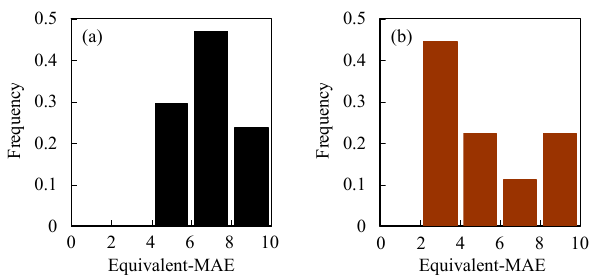
Fig. 3. Frequency distribution of the average equivalent-MAE for Figure 3. Frequency distribution of the average equivalent-MAE for Group 1 (a) and Group 2 (b) Group 1 (a) and Group 2 (b) shown in Table 1. The extremely high value (17.4m 2 g − 1 ) measured in Philadelphia, PA during se- shown in Table 1. The extremely high value (17.4 m 2 /g) measured in Philadelphia, PA during vere sulphate haze episodes occurred in the summer of 2002 was not included in (a) . Upper estimate is used as the average value if severe sulphate haze episodes occurred in the summer of 2002 was not included in Figure 3 (a). the lower estimate is not available (e.g. Hisar, Upper estimate is used as the average value if the lower estimate is not available (e.g. Hisar, India ).